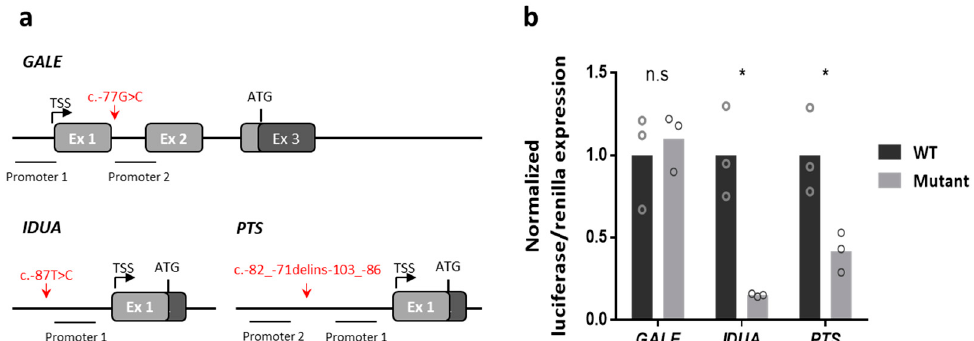
Figure 4. Functional study of 5 ′ UTR variants. ( a ) The proximal promoters identified for the three genes are shown, plus the candidate variants for altering gene expression, the transcription start site (TSS), and the ATG translation initiation codon. Coding exons and non-coding exons are represented in dark and light grey, respectively. Promoter numbering follows that of the Eukaryotic Promoter Database (EPD). ( b ) Normalized luciferase/ renilla expression of the wild-type or mutant promoter of GALE , IDUA and PTS . Results are from three different experiments. Each circle represents the mean of three different replicates (* p < 0.05). n.s: non-significant.